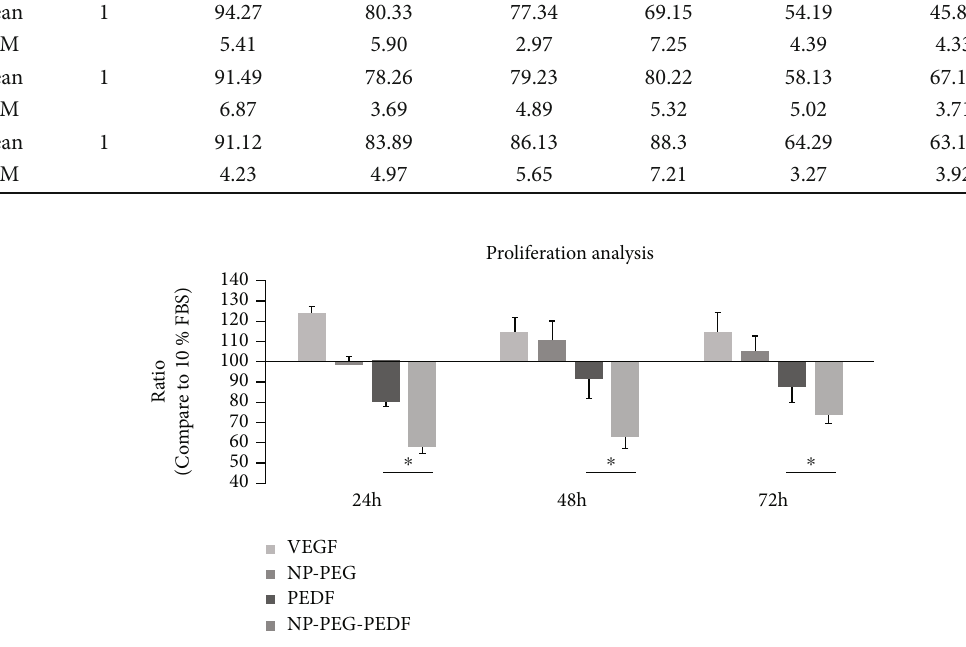
Figure 3: E ff ects of PEDF and NP-PEG-PEDF on the proliferation of HUVECs with VEGF stimulation under high glucose (30 mmol/L) at 24, 48, and 72 h. The e ff ective concentrations (1000ng/mL) at di ff erent time points are shown. ∗ p < 0 : 05